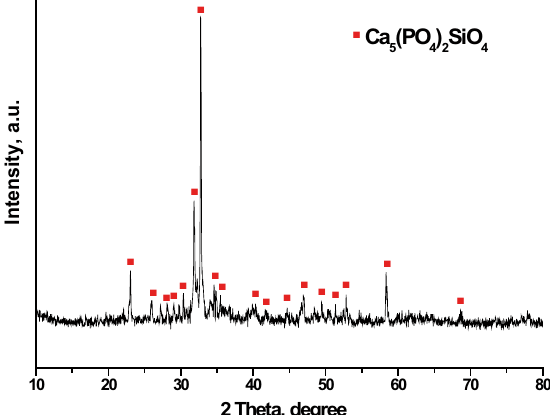
Figure 5. XRD of collagen/silicocarnotite (25:75 wt%) before immersion in 1.5SBF